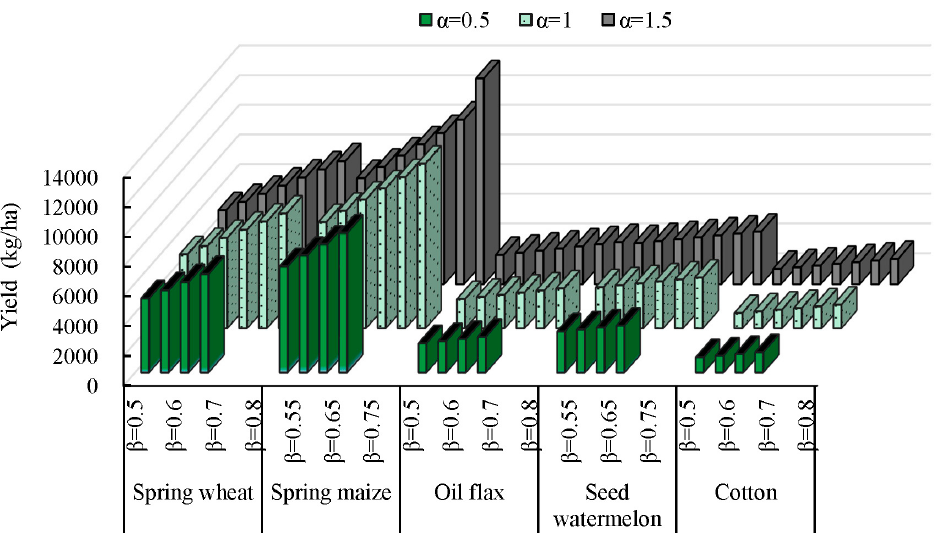
Figure 6. Yield for different crops under different scenarios.